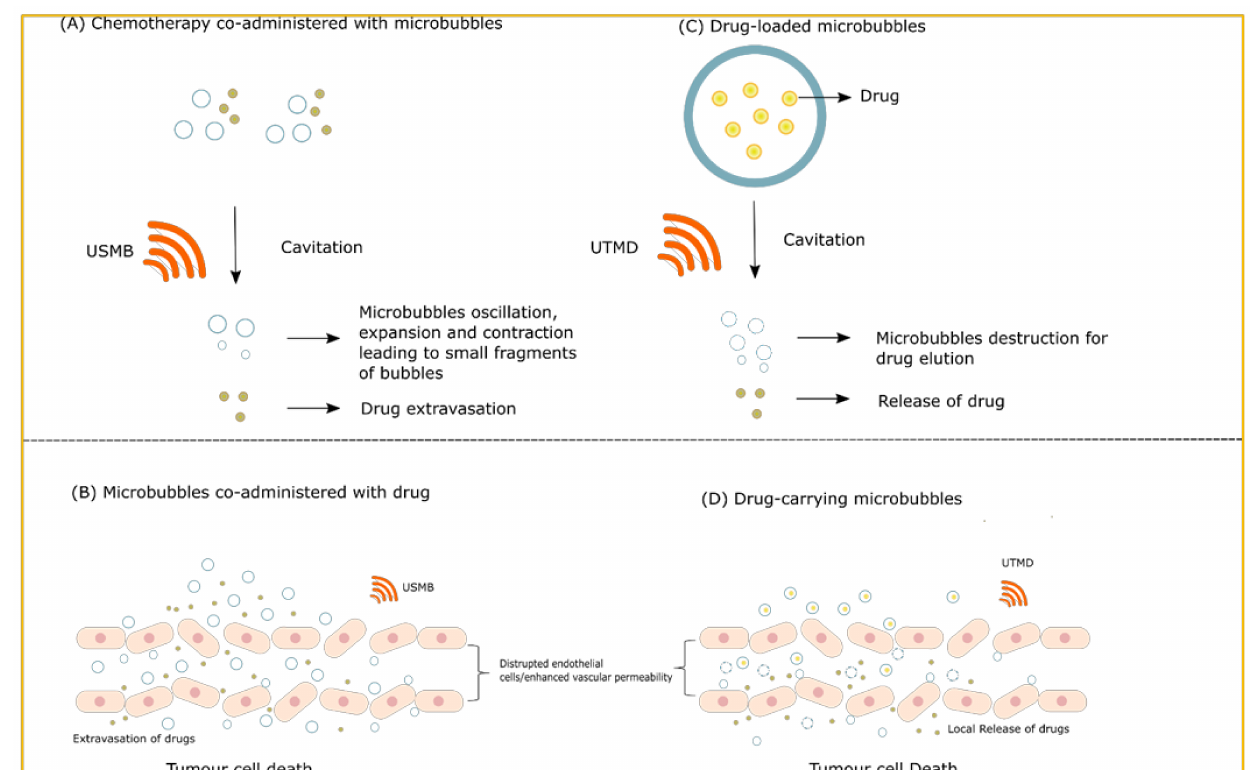
Figure 3. Illustration of drug delivery in conjugation with ultrasound and MB. ( A ) The drug can be co-injected with MB followed by ultrasound exposure to cause bubbles cavitation and its destruction leading to drug extravasation. ( B ) The image depicts the effect of co-administration of MB and drugs in ultrasound-guided drug delivery. USMB-induced sonoporation leads to increase vessel permeability allowing the uptake of drugs by the tumour cells causing them to destroy. ( C ) The drug can be delivered by loading them onto MB followed by an application of ultrasound acoustic pressure, the process known as ultrasound-targeted microbubble destruction (UTMD). The drug is eluted from MB causing its local release to the targeted site. ( D ) The image illustrates the effects of drug-loaded MB combined with ultrasound. UTMD enhances the efficacy of several drugs and their uptake by tumour cells through the effects of sonoporation. XRT = radiotherapy; USMB = ultrasound- stimulated